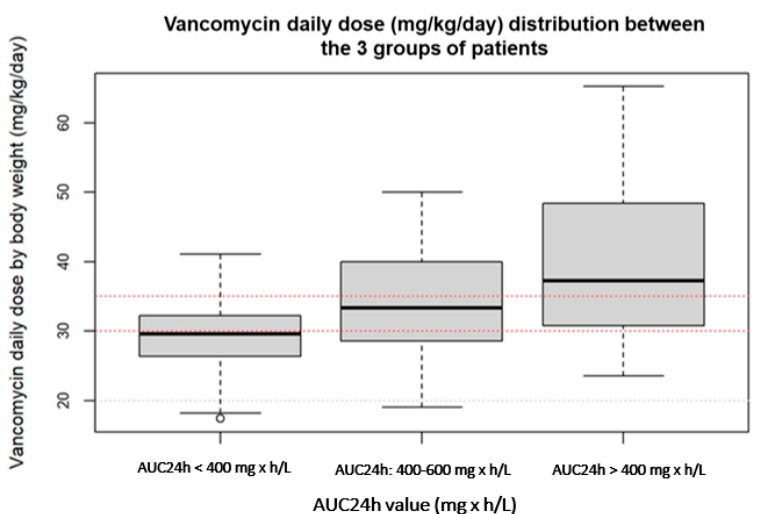
Figure 1. Distribution of the vancomycin daily dose values between patients with a suboptimal, optimal and supratherapeutic PKPD target.